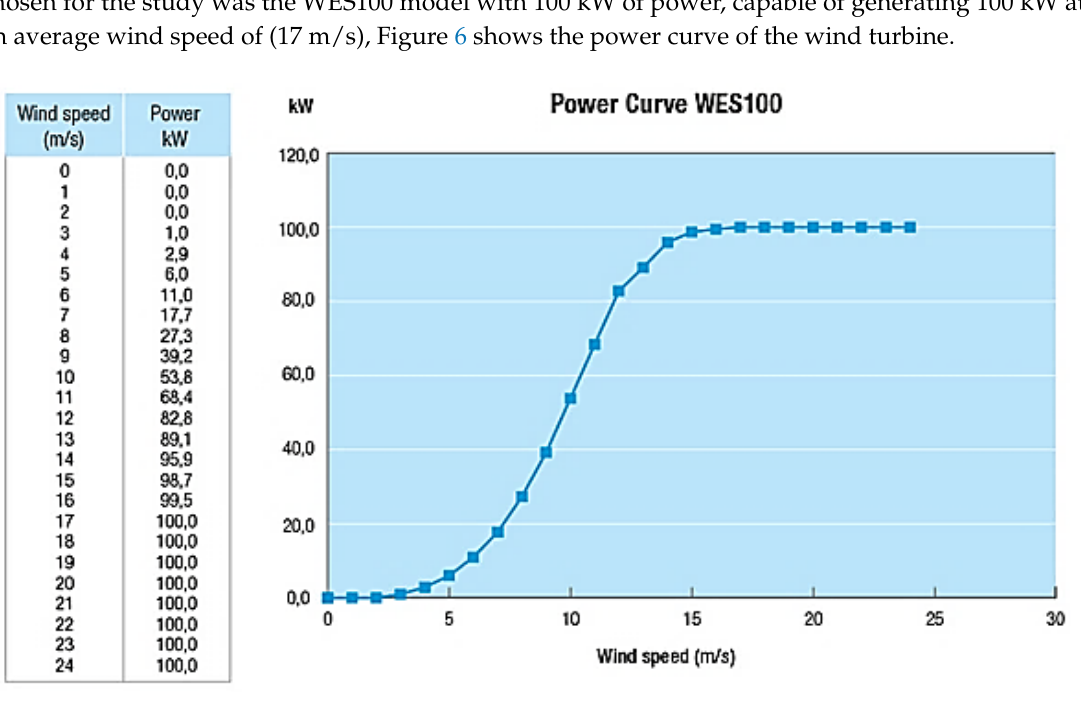
Figure 6. Power curve of the WES100 wind turbine. Source: http://www.energiapura.com/aerogerador-wes-100.